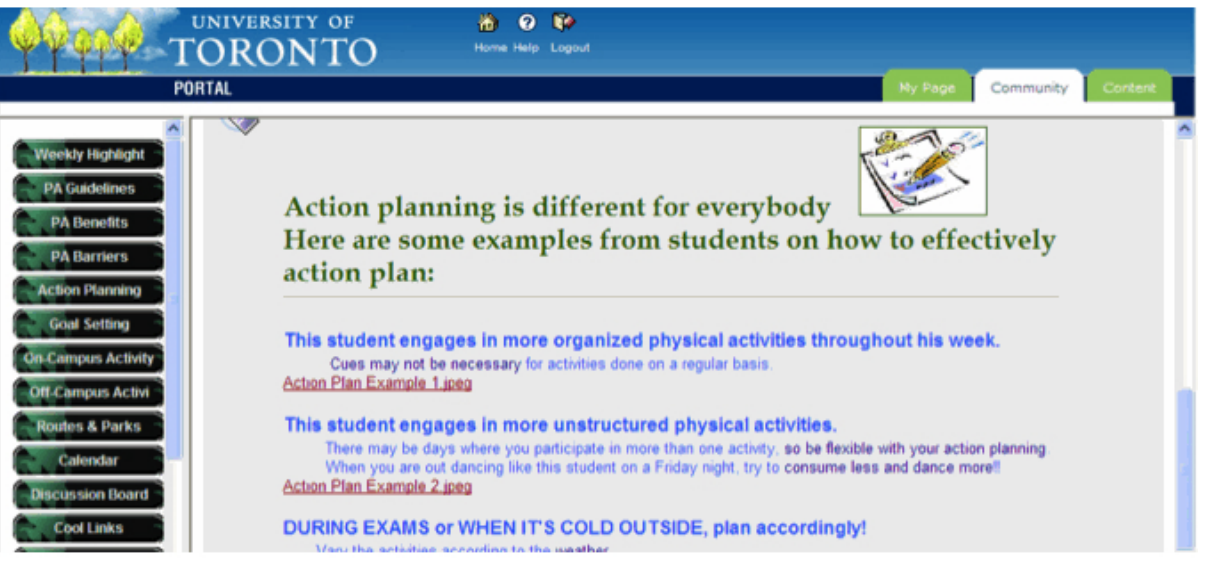
Figure 1. Screenshot of the intervention topic on action